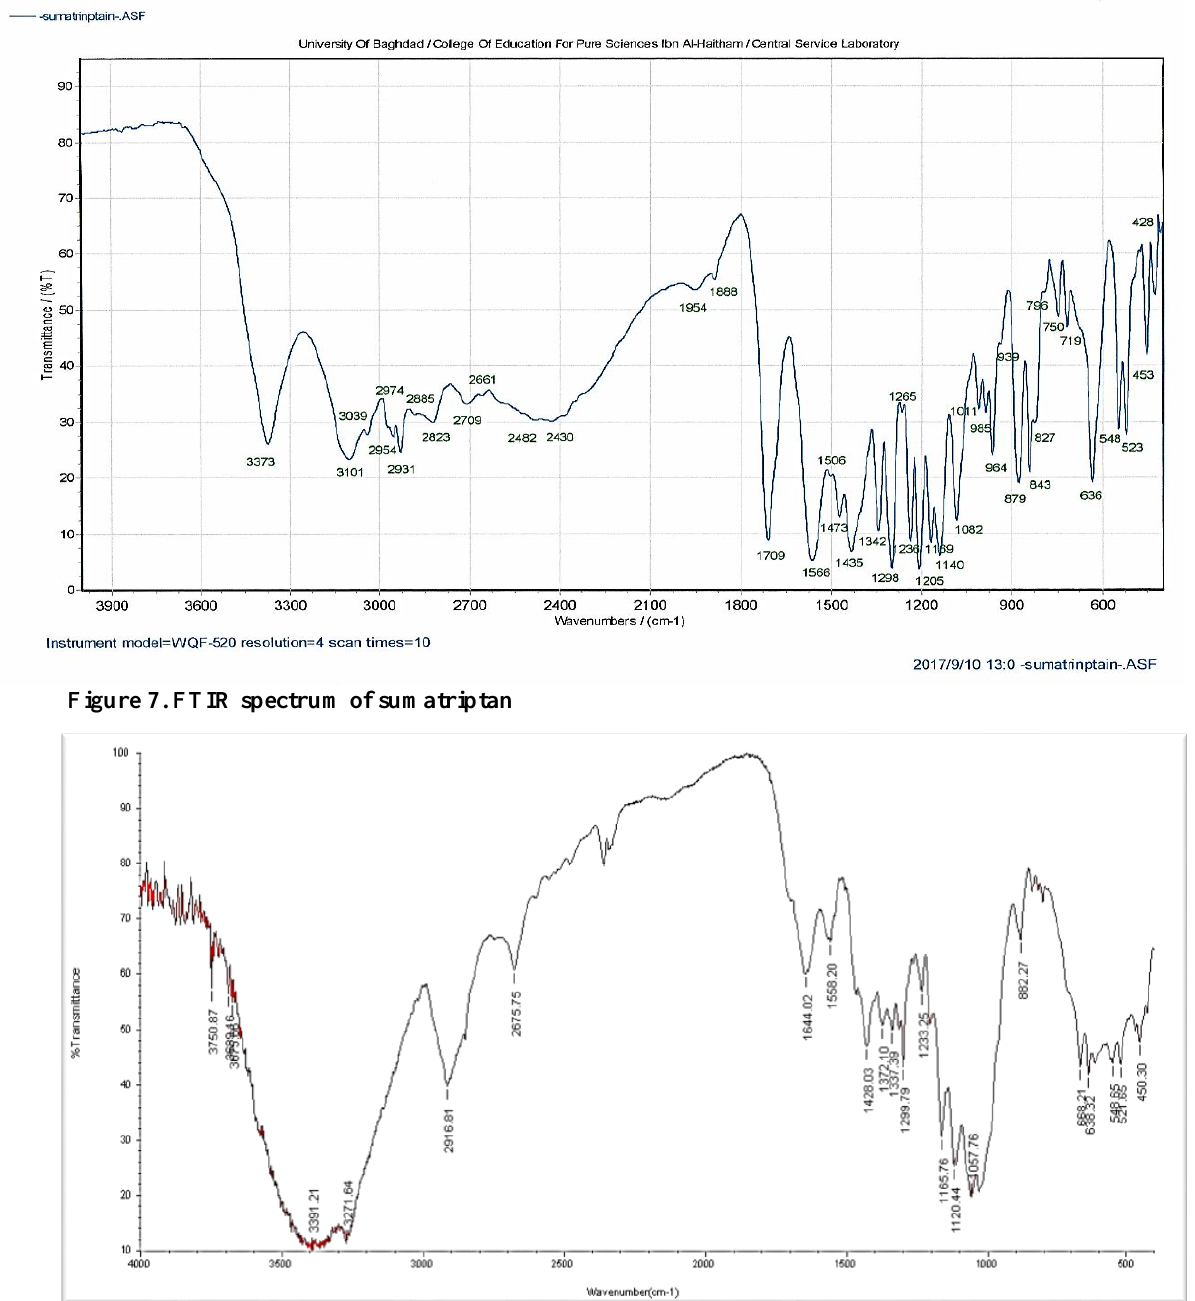
Figure 8. FTIR spectrum of the selected formula of sumatriptan core tablet